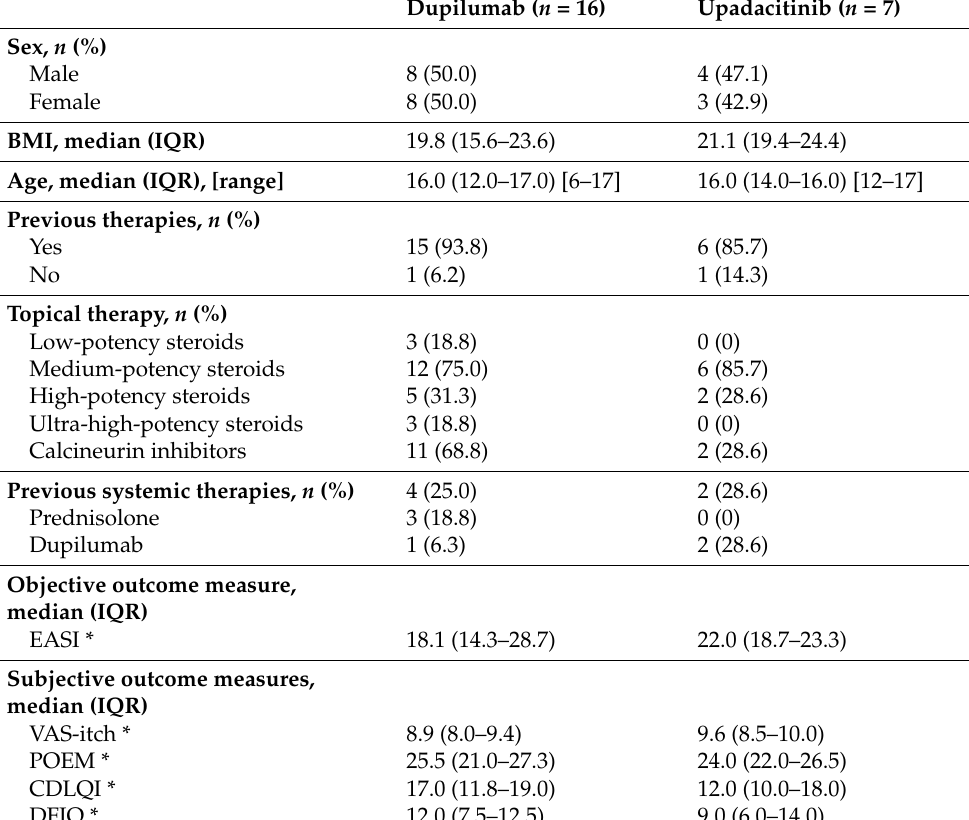
Table 2. Baseline demographics and clinical characteristics of the